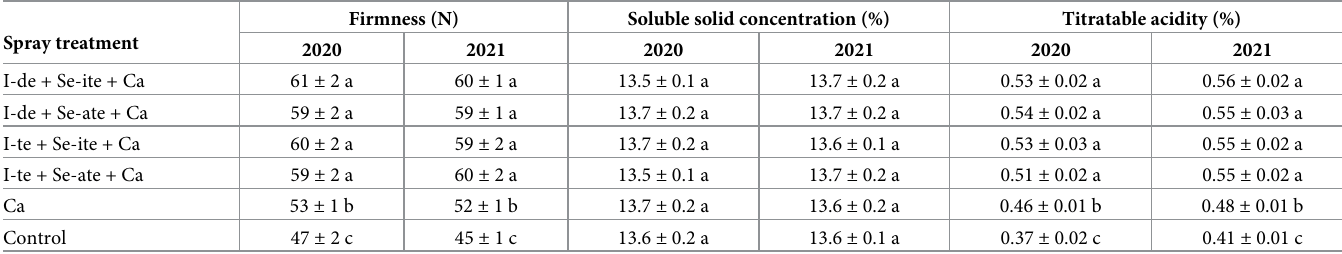
Means with the same letter within each column are not significantly different by Tukey’s multiple range test at α = 0.05.